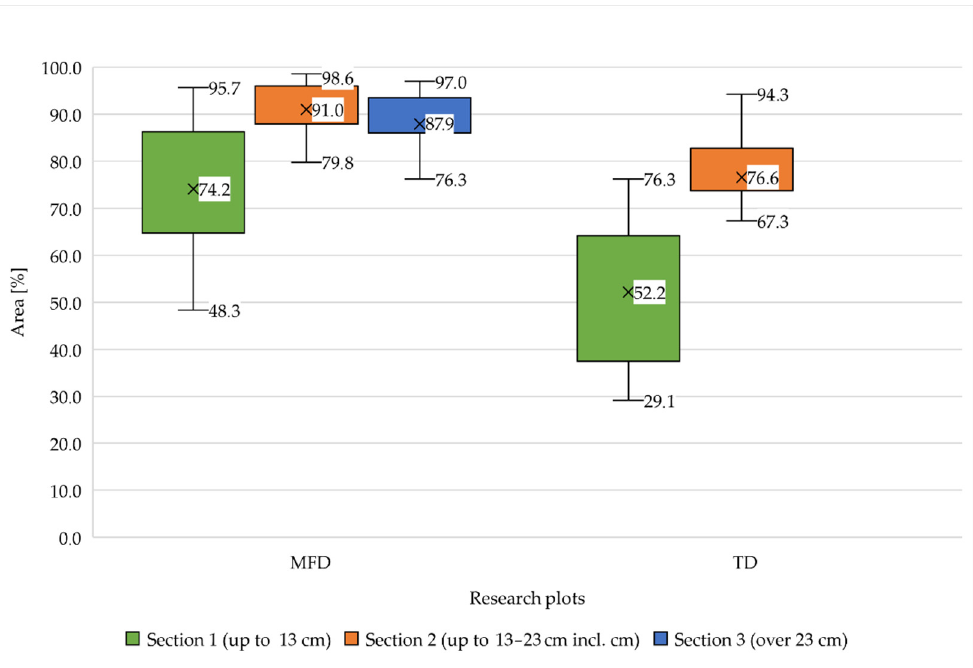
Figure 4. Debarking quality of the logs.